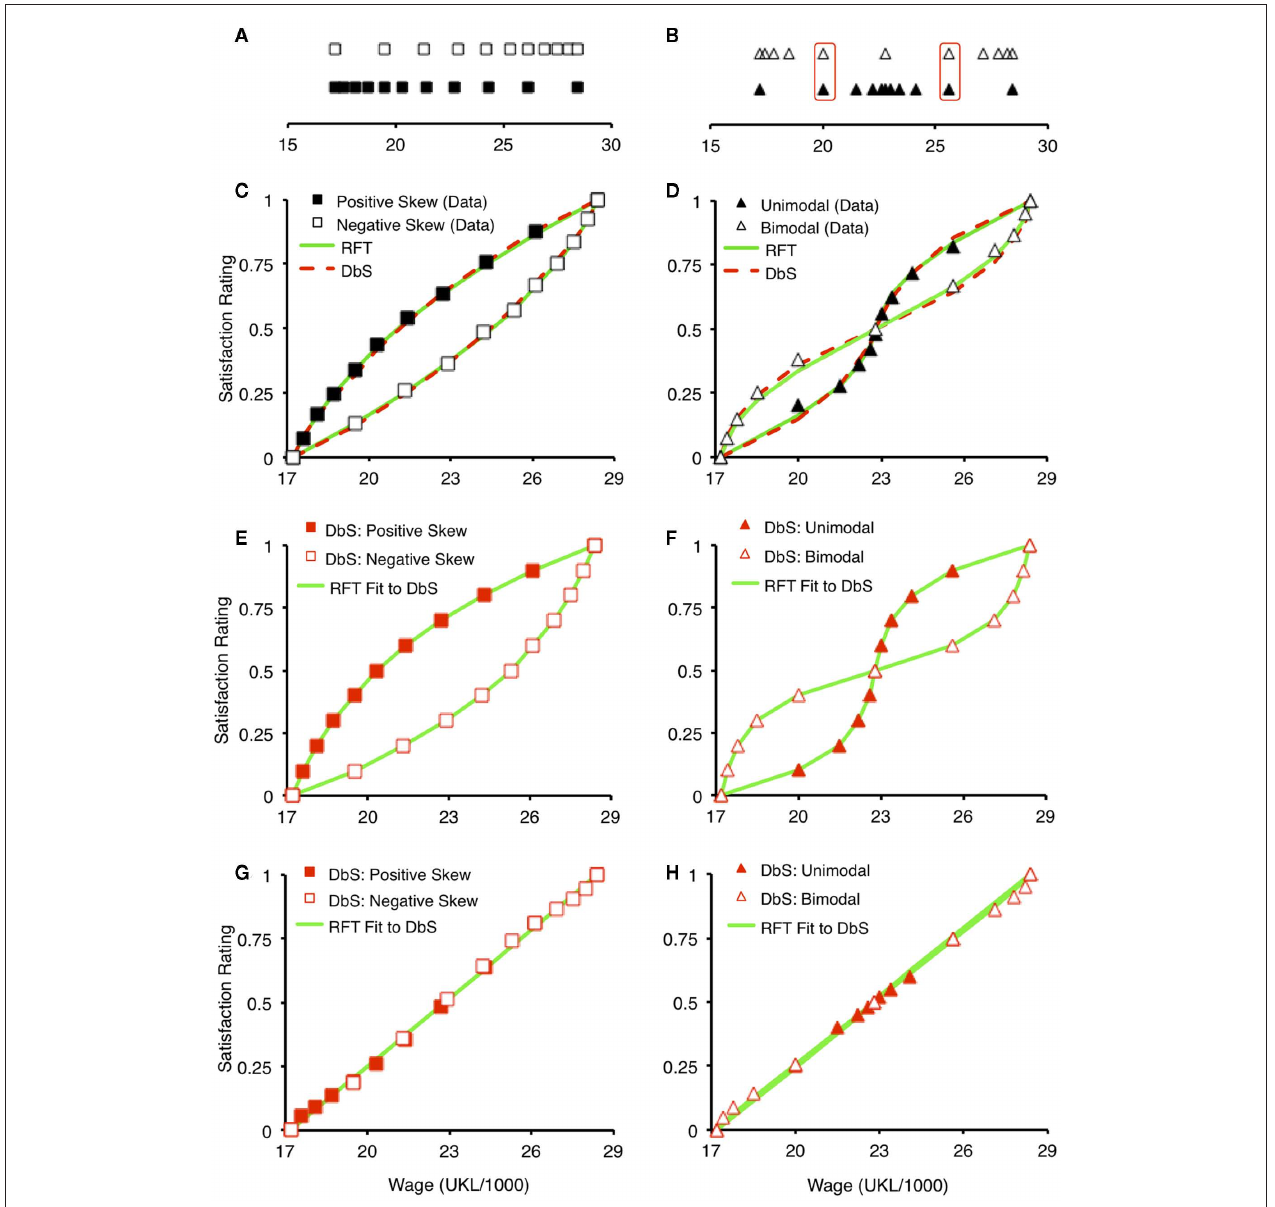
Figure 1 | Comparison of the predictions of rFT and the combined DbS-SiMPLe model (see text for details). (A) Positively and negatively skewed wage distributions. (B) Bimodal and unimodal wage distributions. (C,D) Fit of RFT and DbS-SIMPLE to wage satisfaction judgments. (e,F)